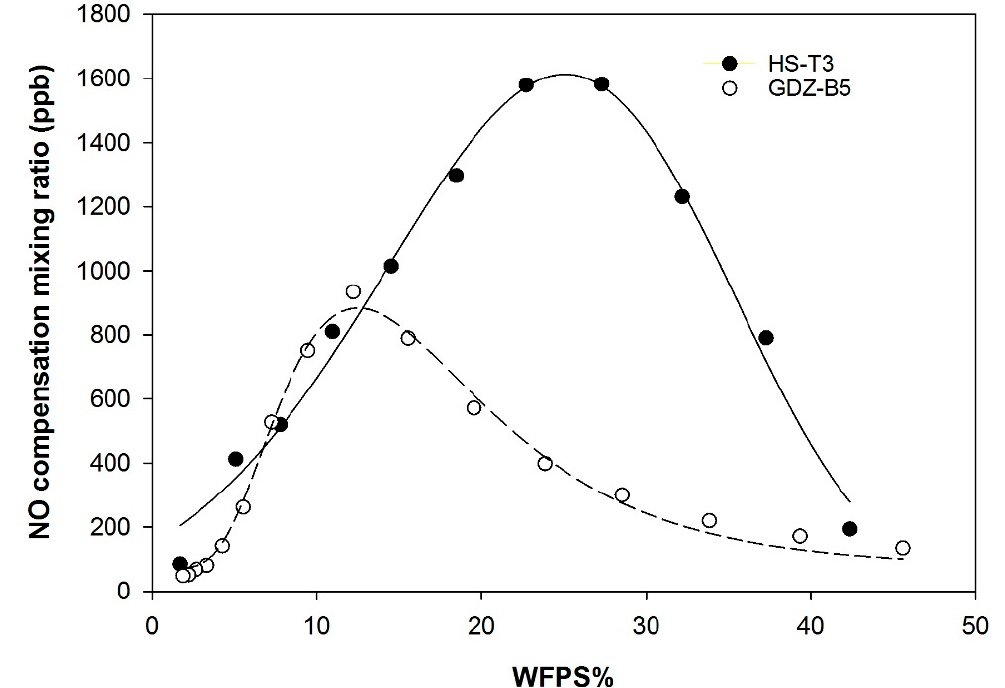
Figure 4. NO compensation mixing ratios at 30 ◦ C as a function of WFPS for soils HS-T3 and GDZ-B5 (calculated based on Equation (2)).